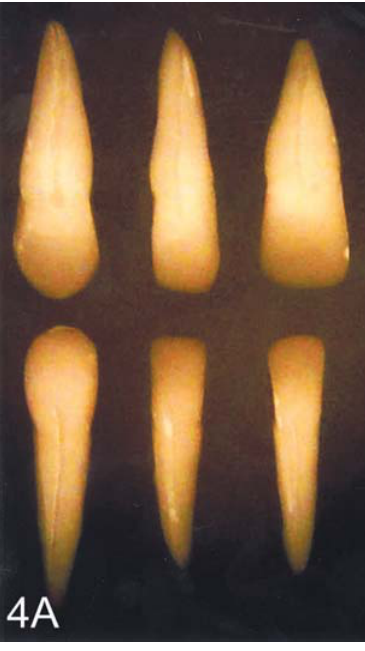
FIGURE 4C- Radiographic image of cloudy resin molars